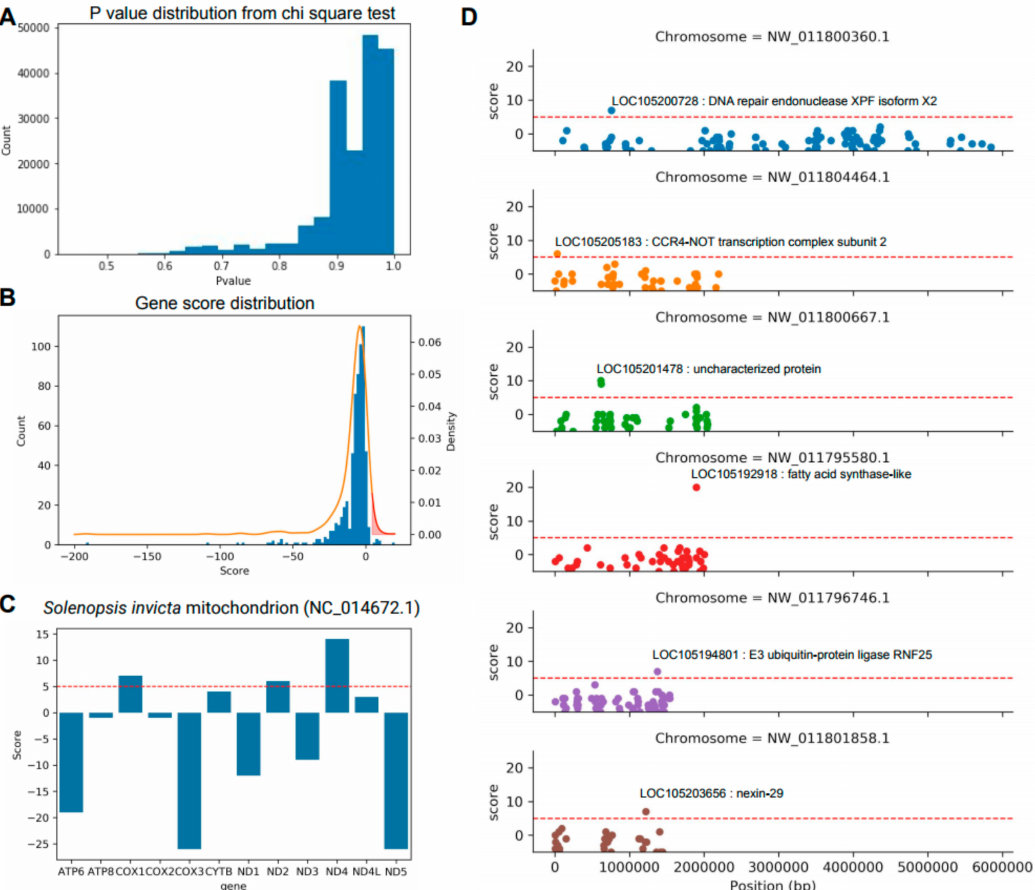
Figure 3. Listing the key sites and genes by the chi-square test and gene-based scoring scheme. ( A ) P -value distribution of the Chi-square test. ( B ) Score distribution for the genes by p -values from the chi-square test. The red shaded region shows the area higher than threshold score 5. ( C ) Scores for the genes in the mitochondria genome. ( D ) Scatter plot of scores for the genes in selected chromosomes. The labeled genes showed a score higher than 5. The red dot lines in ( C,D ) indicates determined threshold score